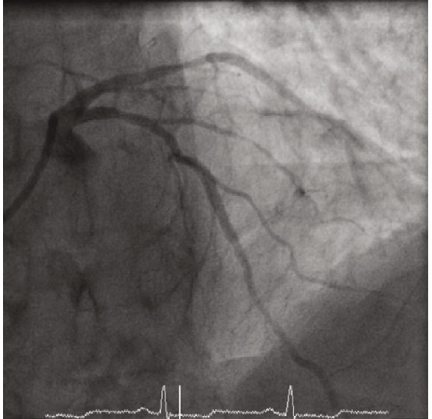
Figure 4: Ventricular fi